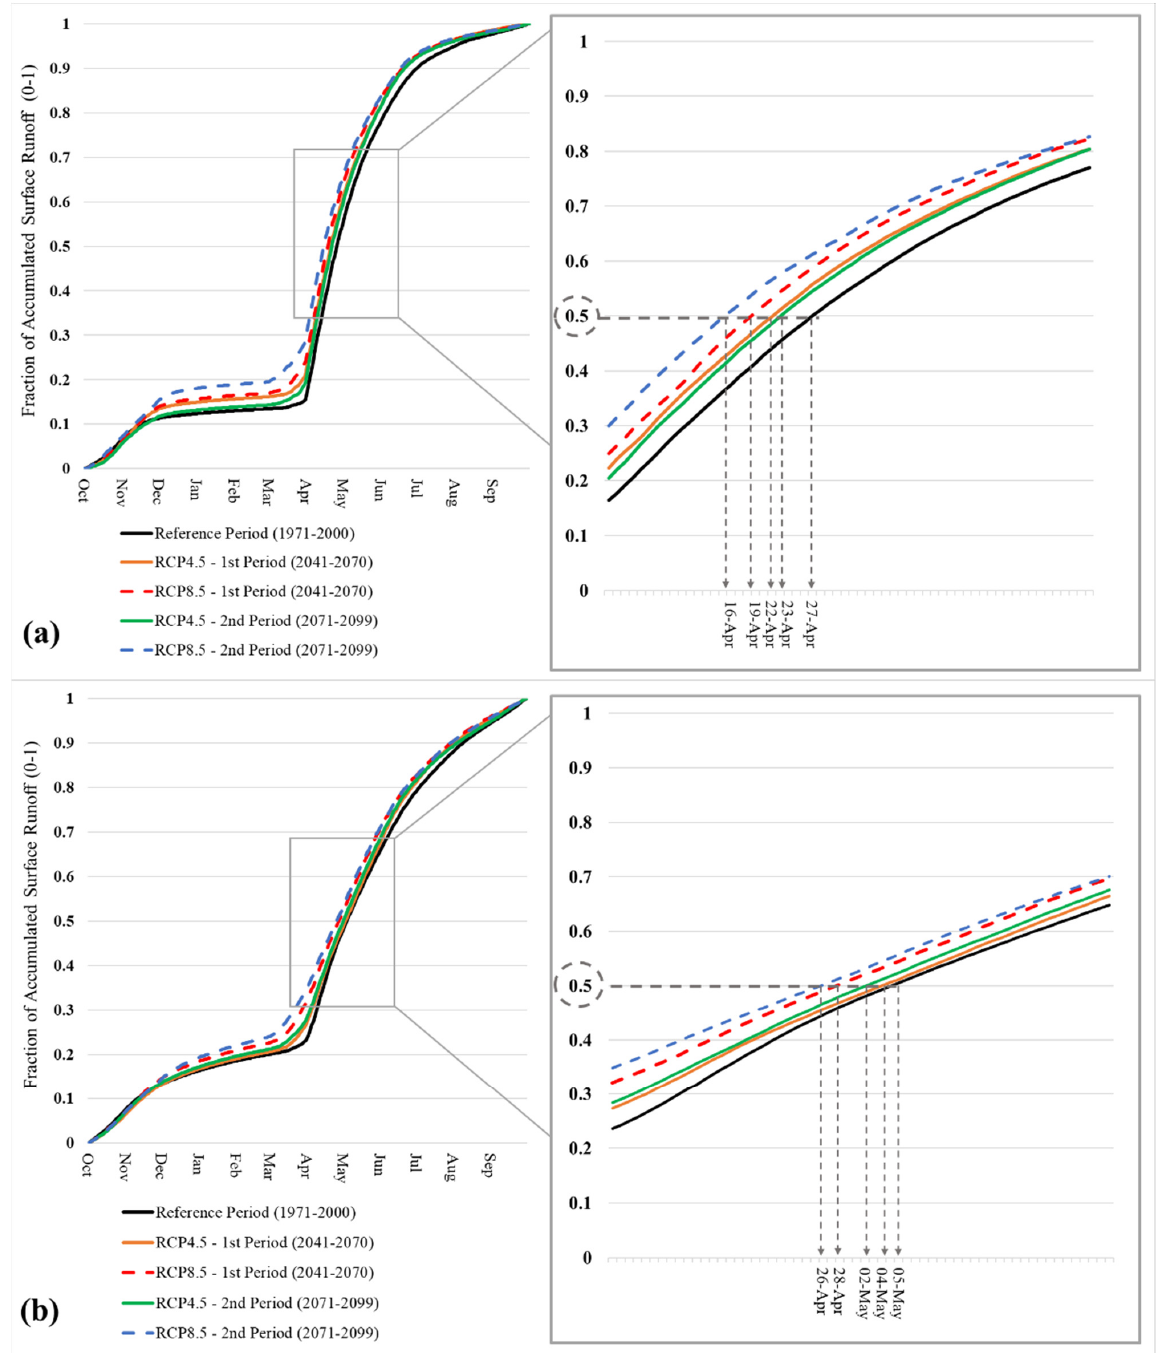
Figure 12. Center-time changes for ( a ) Murat and ( b ) Karasu basin.